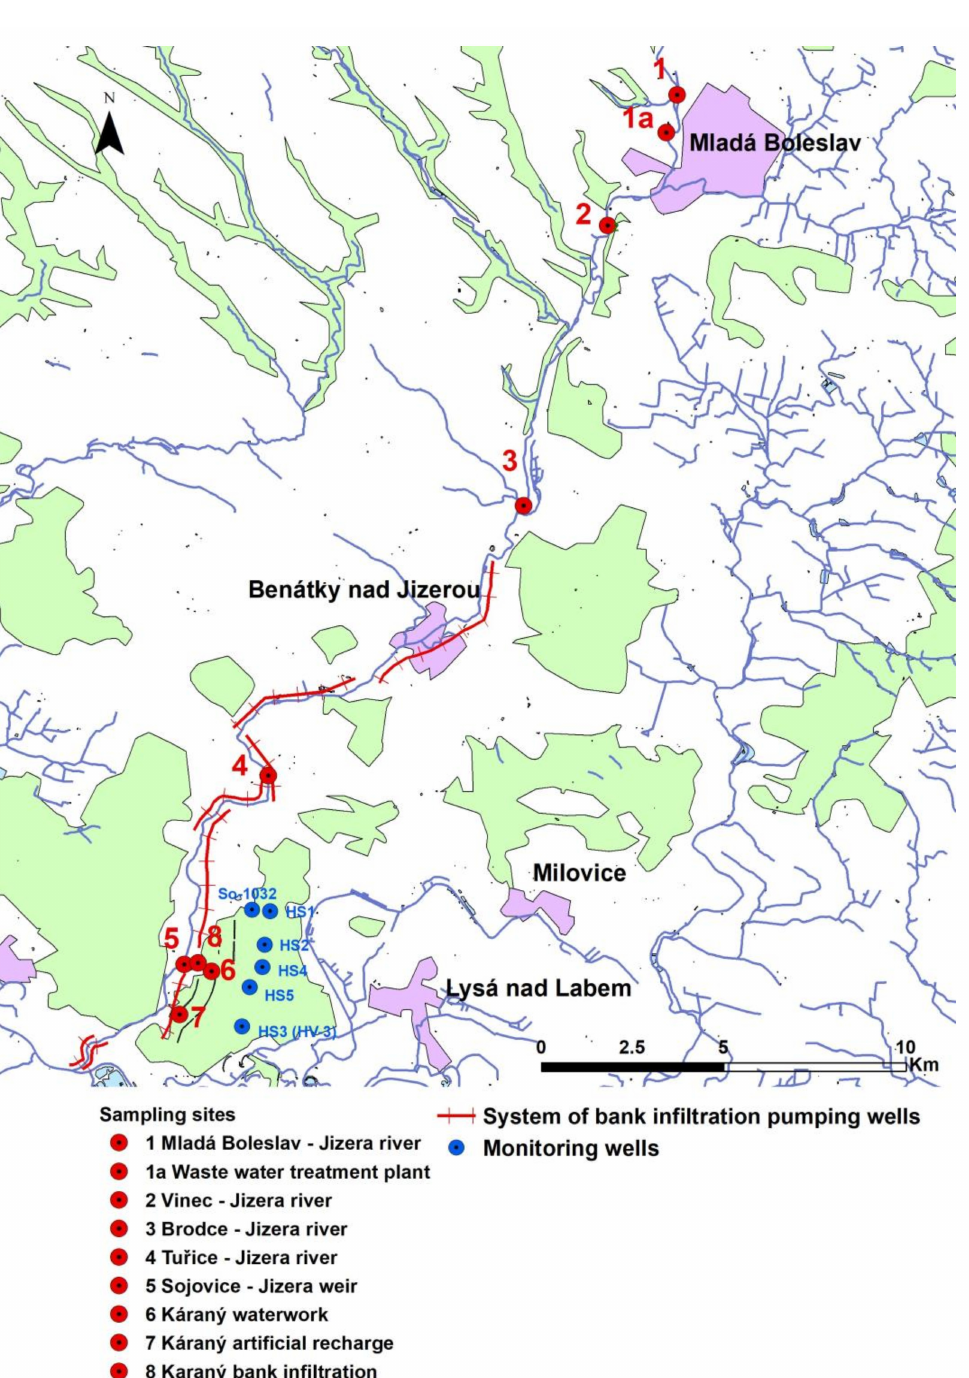
Figure 1. Sampling sites on the Jizera